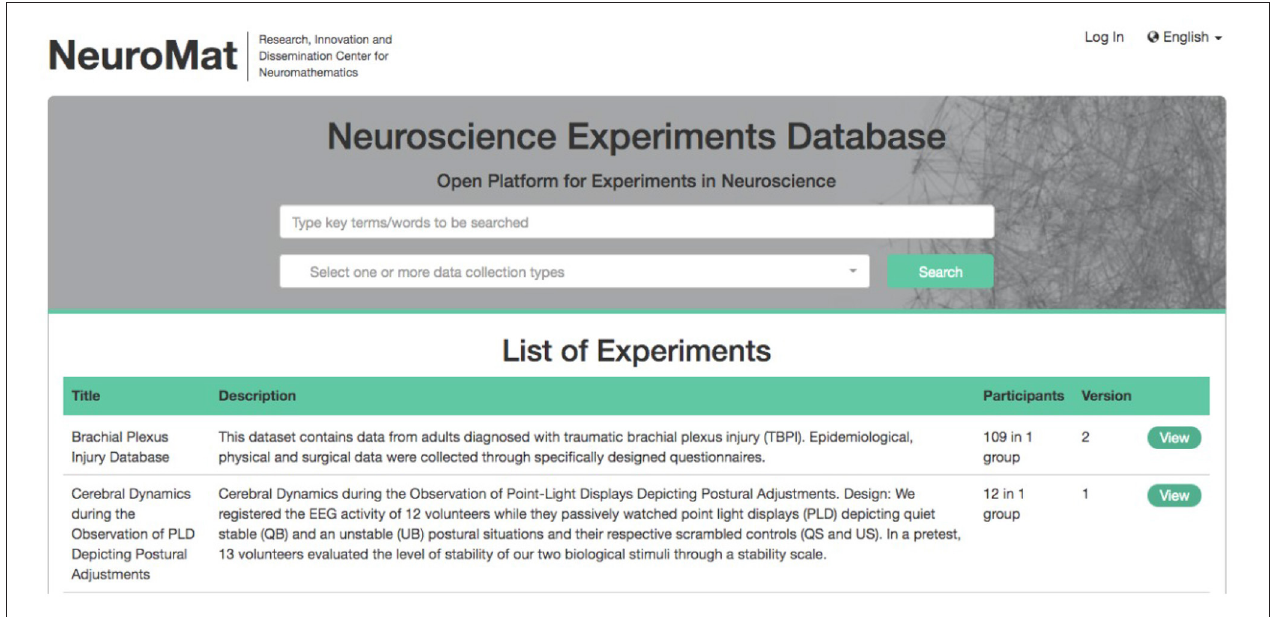
FIGURE 13 | NeuroMat Open Database (NeuroMat DB) home page.